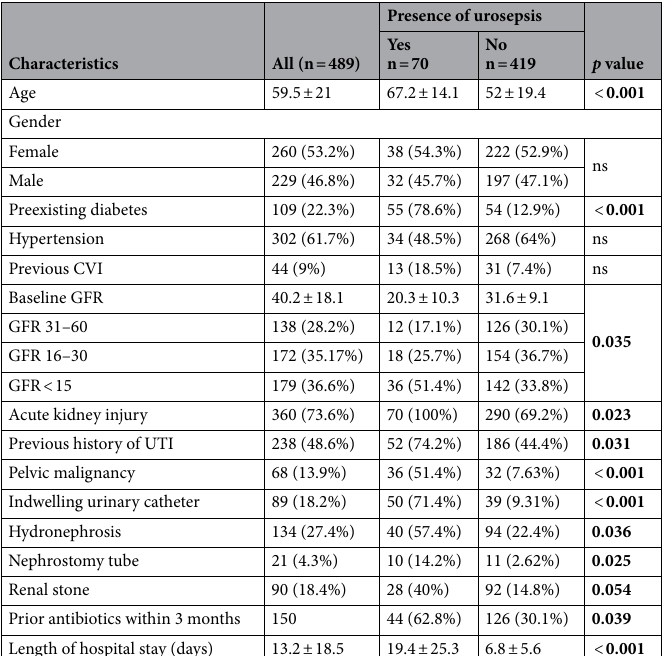
Table 1. Baseline demographic, clinical, and laboratory characteristics of the patients with complicated urinary tract infection. Bold values denote statistical significance at the p < 0.05 level. CVI cerebrovascular insult, G FR glomerular filtration rate, ns non-significant.